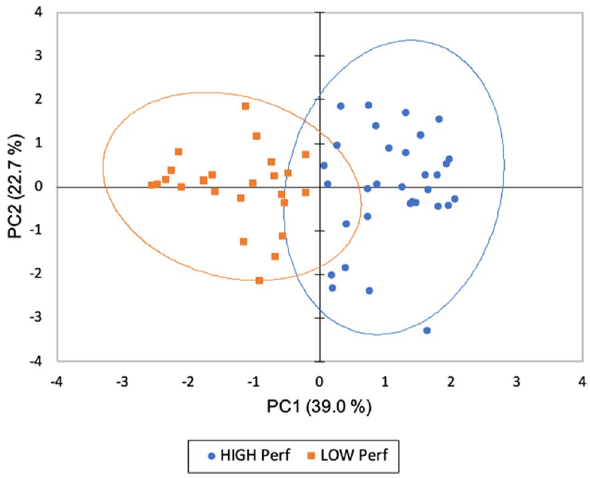
Figure 4. Bi-plots from Principal Component Analysis with confidence ellipses (confidence level 95%) conducted on variables related to smell and taste measurements (Identification Smell Score, Intensity Smell Score, Irritation Smell Score, Identification Taste Score, Intensity Taste Score) obtained for COVID group (n = 61). Patients characterized by a low and high sensory performance are displayed in orange ( LOW Perf ) and blue ( HIGH Perf ), respectively.